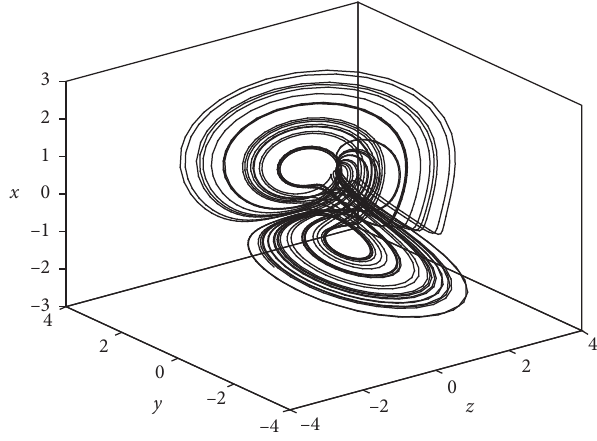
Figure 1: A new chaotic attractor.